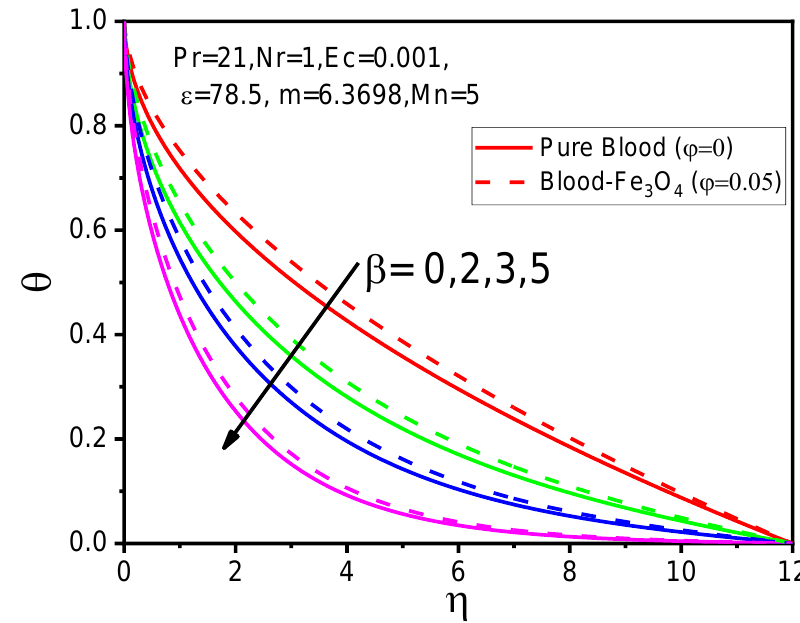
' F for 10,9,8 = against